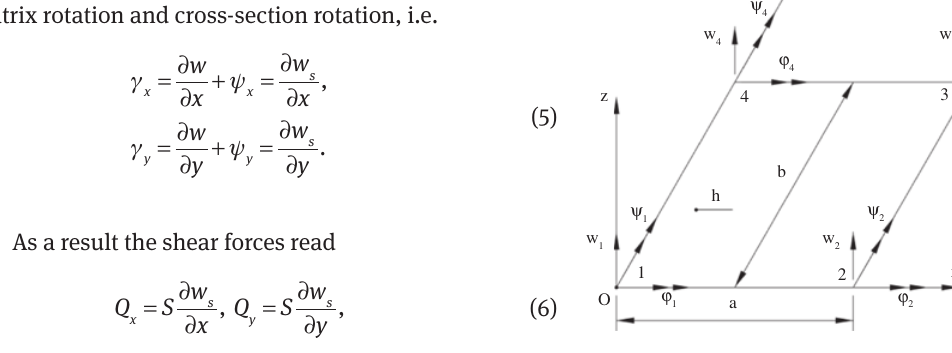
Figure 2: Rectangular finite element with nodal